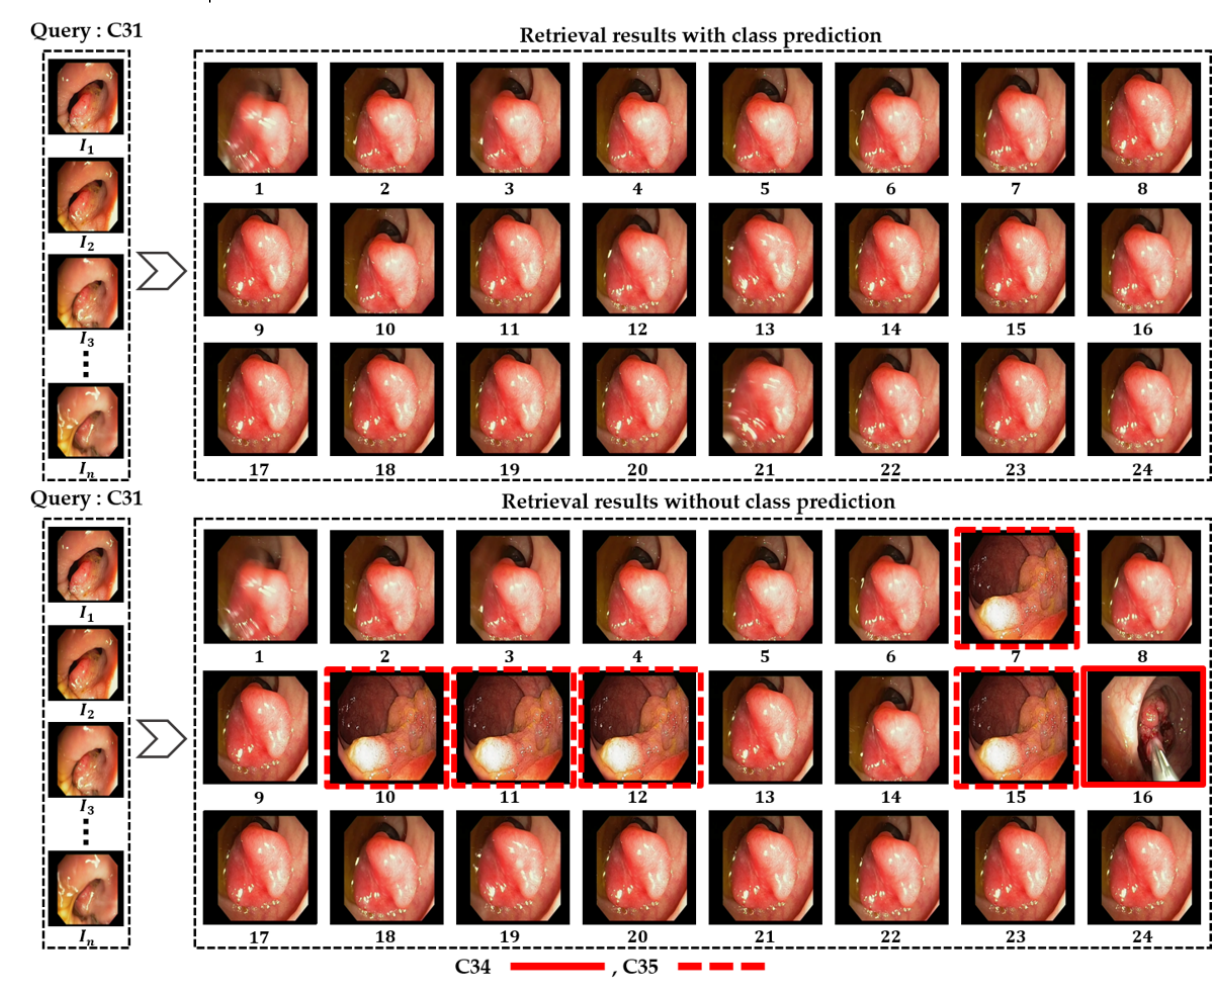
Figure 8. Obtained retrieval results in ranked order (1st to 24th best matches) for the C31 input query frame using both a class prediction–based method and a method without class